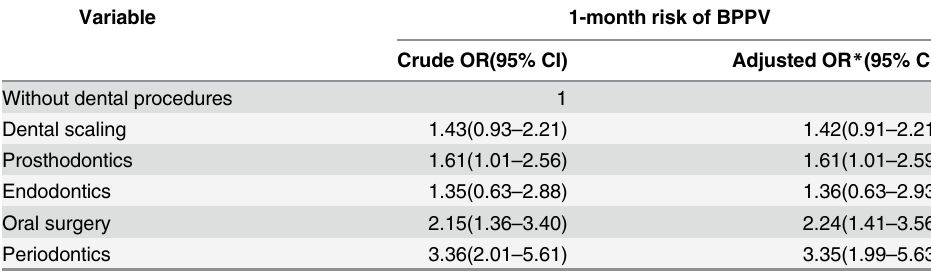
Table 4. Odds ratios for benign paroxysmal positional vertigo associated with different kinds of den- tal